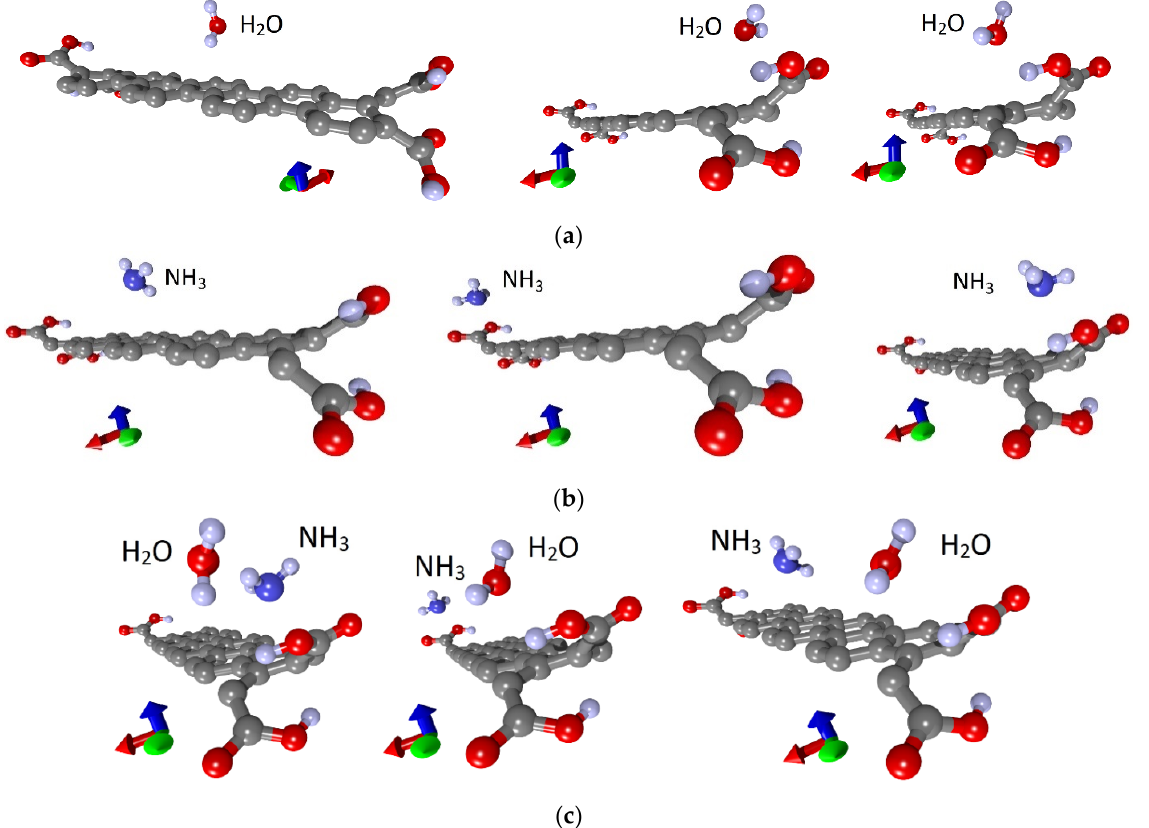
Figure 3. Adsorption of water and ammonia: ( a ) water molecules; ( b ) ammonia molecules on a dry nanoribbon; ( c ) ammonia molecules on a wet nanoribbon (one supercell of 32ZGRNR–4COOH nanoribbon is shown).